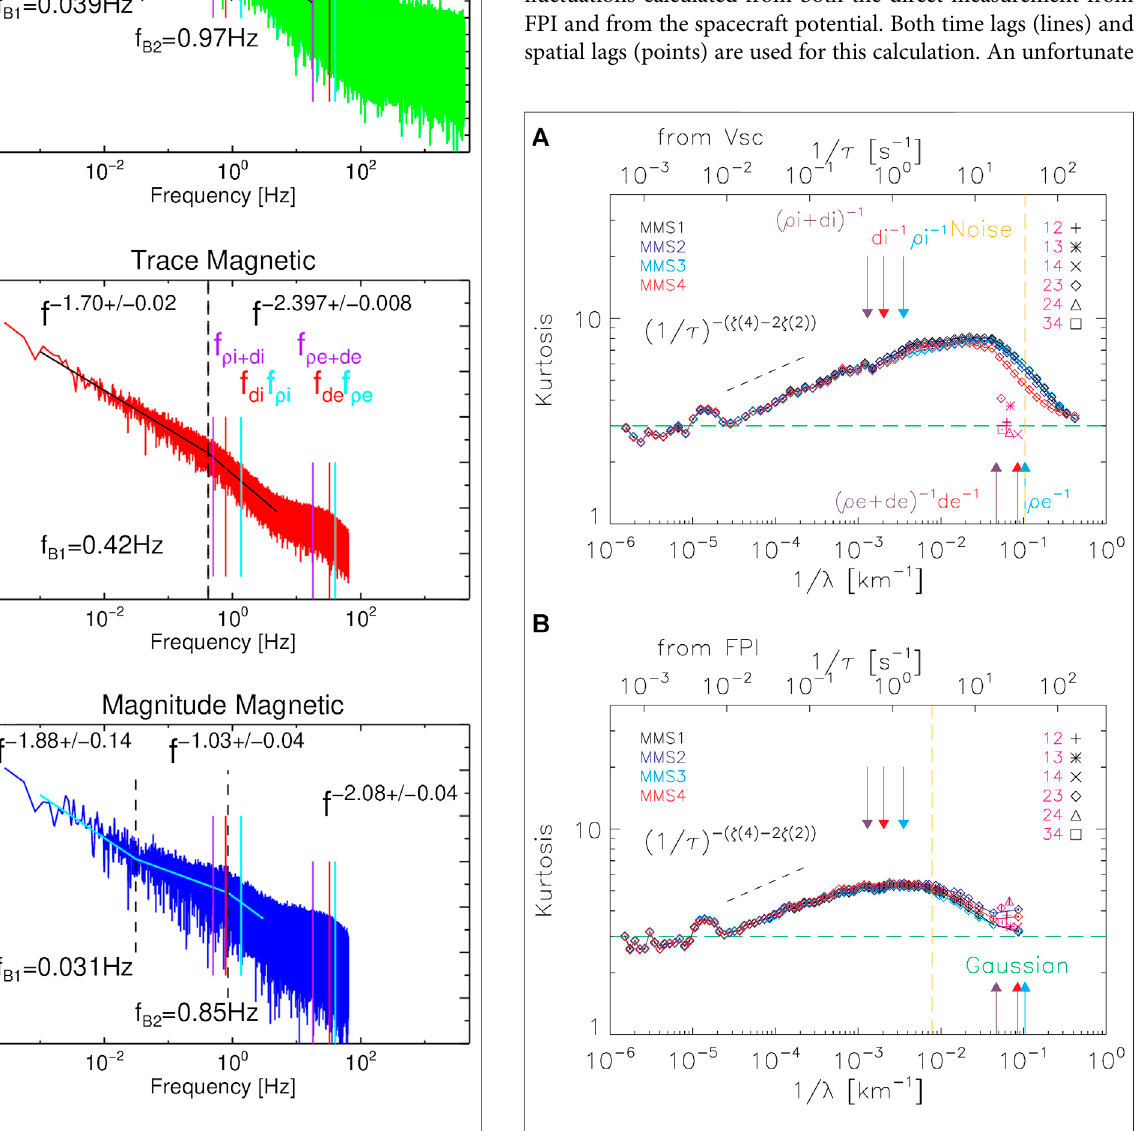
FIGURE 3 | Scale-dependent kurtosis for electron density fl uctuations obtained from the spacecraft potential (A) and FPI (B) . The orange vertical line denotes the region where instrumental noise becomes signi fi cant for the two different measurements. The green horizontal line denotes a kurtosis of 3, characteristic of a Gaussian process. The arrows denote the same characteristic scales as previously in Figure 2 . The lines denote the time- lagged values from different spacecraft, and the pink data points denote the kurtosis calculated from two spacecraft measurements. Black-dashed lines indicate power-laws expected from the scaling of the structure functions, and are displayed for reference. Error bars are indicated based on 100 bootstrap resamplings but they are smaller than the plotting